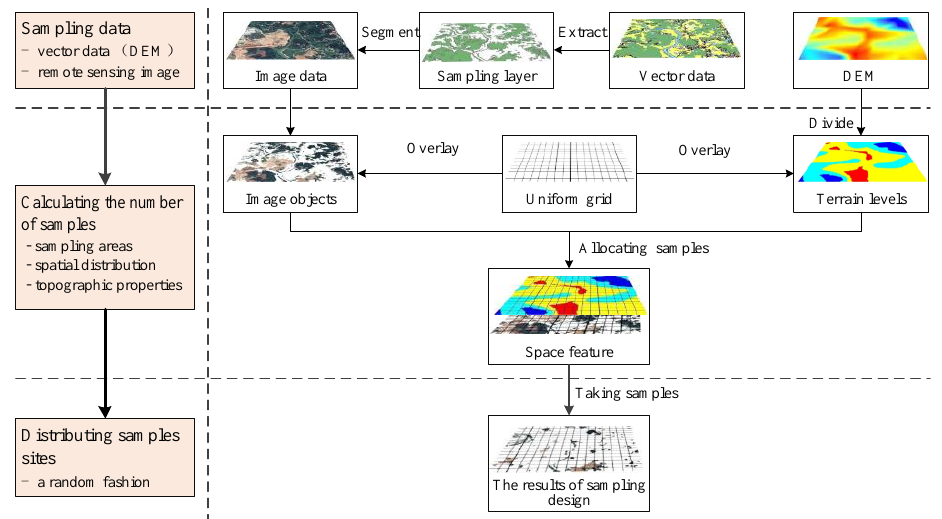
Figure 2. The principle of sampling design.